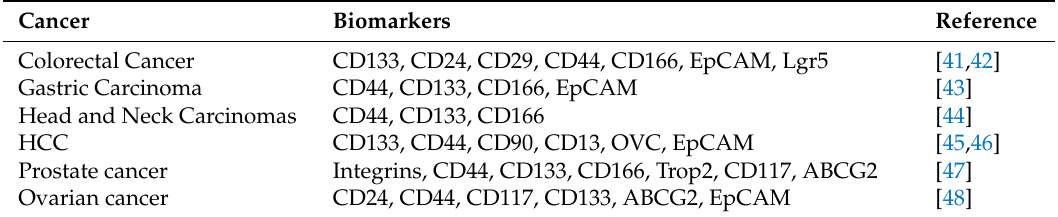
Table 1. Cancer stem cells (CSCs) biomarkers in various